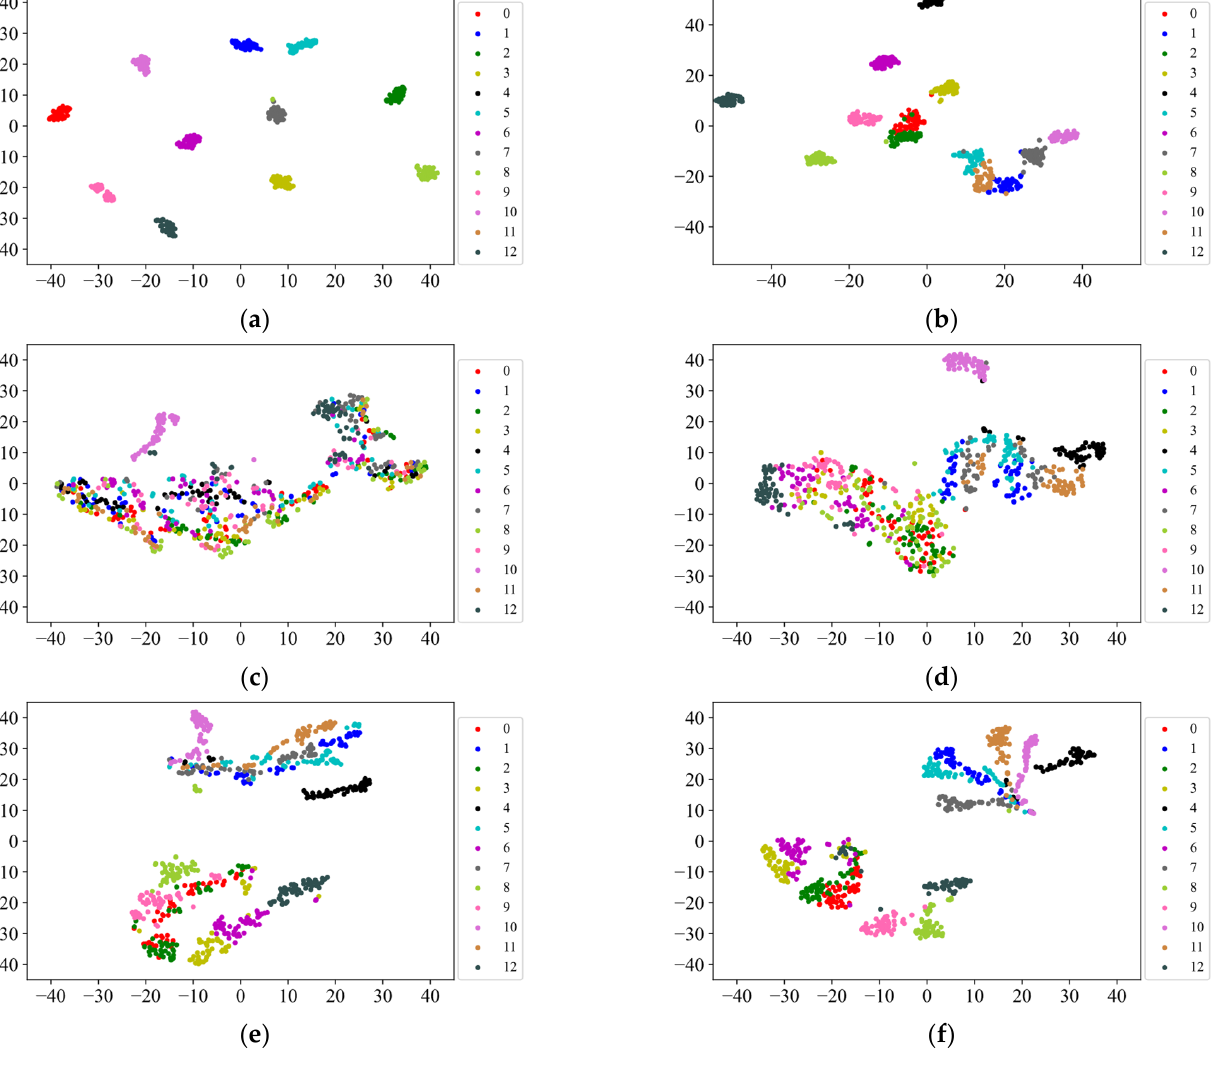
Figure 14. The visualization of feature extractors on labeled aero-engine bearing dataset 3. ( a ) SMoCo; ( b ) labeled pretraining; ( c ) Wang; ( d ) SimCLR; ( e ) BYOL; ( f ) MoCo.